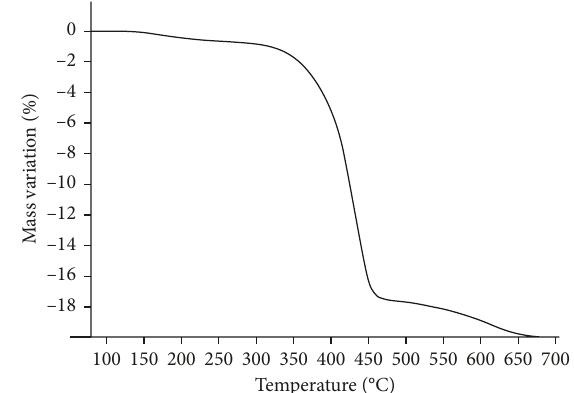
Figure 10: Mass variation of GFRP bar specimen when heated between 20 ° C and 800 ° C (adapted from [25]).